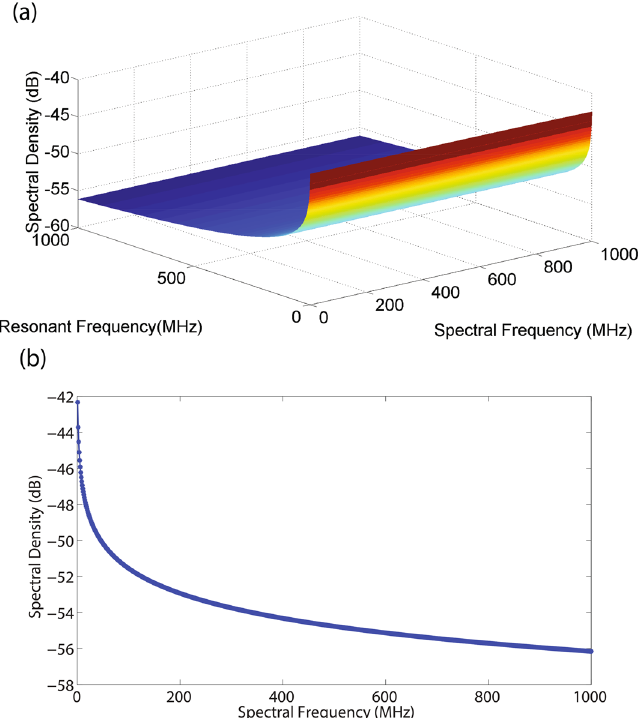
Figure 9. Brownian noise of a particle in a potential ( a ) Variation of spectral density with resonant frequency of the particle and spectral frequency. Noise has a uniform spectral distribution with frequency,however, there is an increase in noise with a reduction in resonant frequency of the system. Here, the spectral and and resonant frequencies are varied from 0 to 1 GHz. ( b ) Spectral density of noise reduces with an increase in time saturating to a final value steady state value. Here, the spectral frequency is varied from 0 to 1GHz